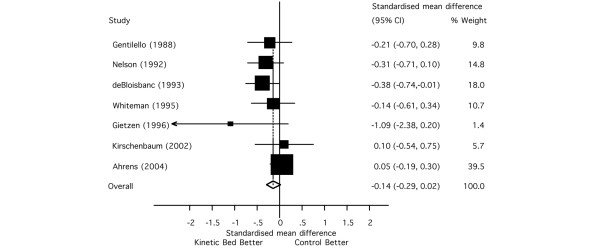
Forest plot showing the effect of kinetic bed therapy on duration of mechanical ventilation. CI, confidence interval.